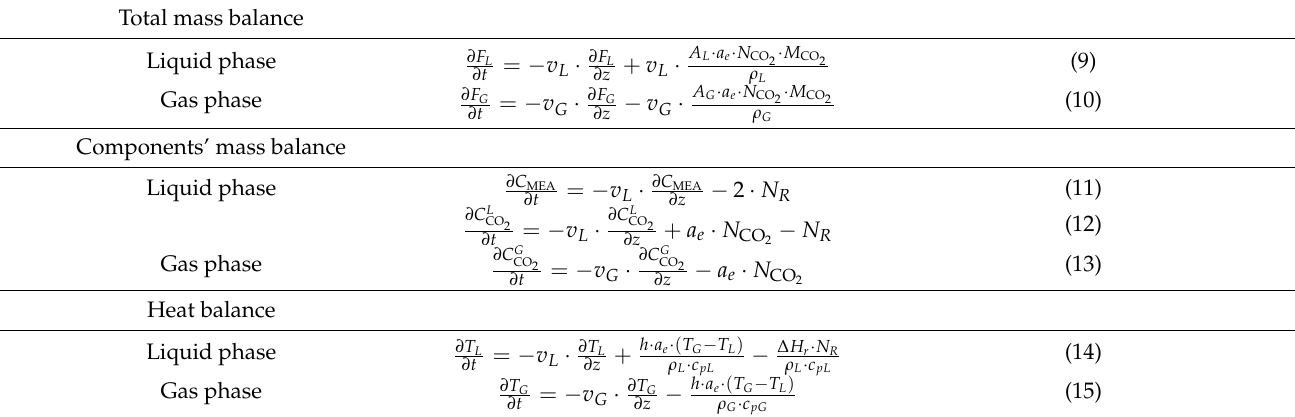
Table 1. Dynamic mathematical model balance